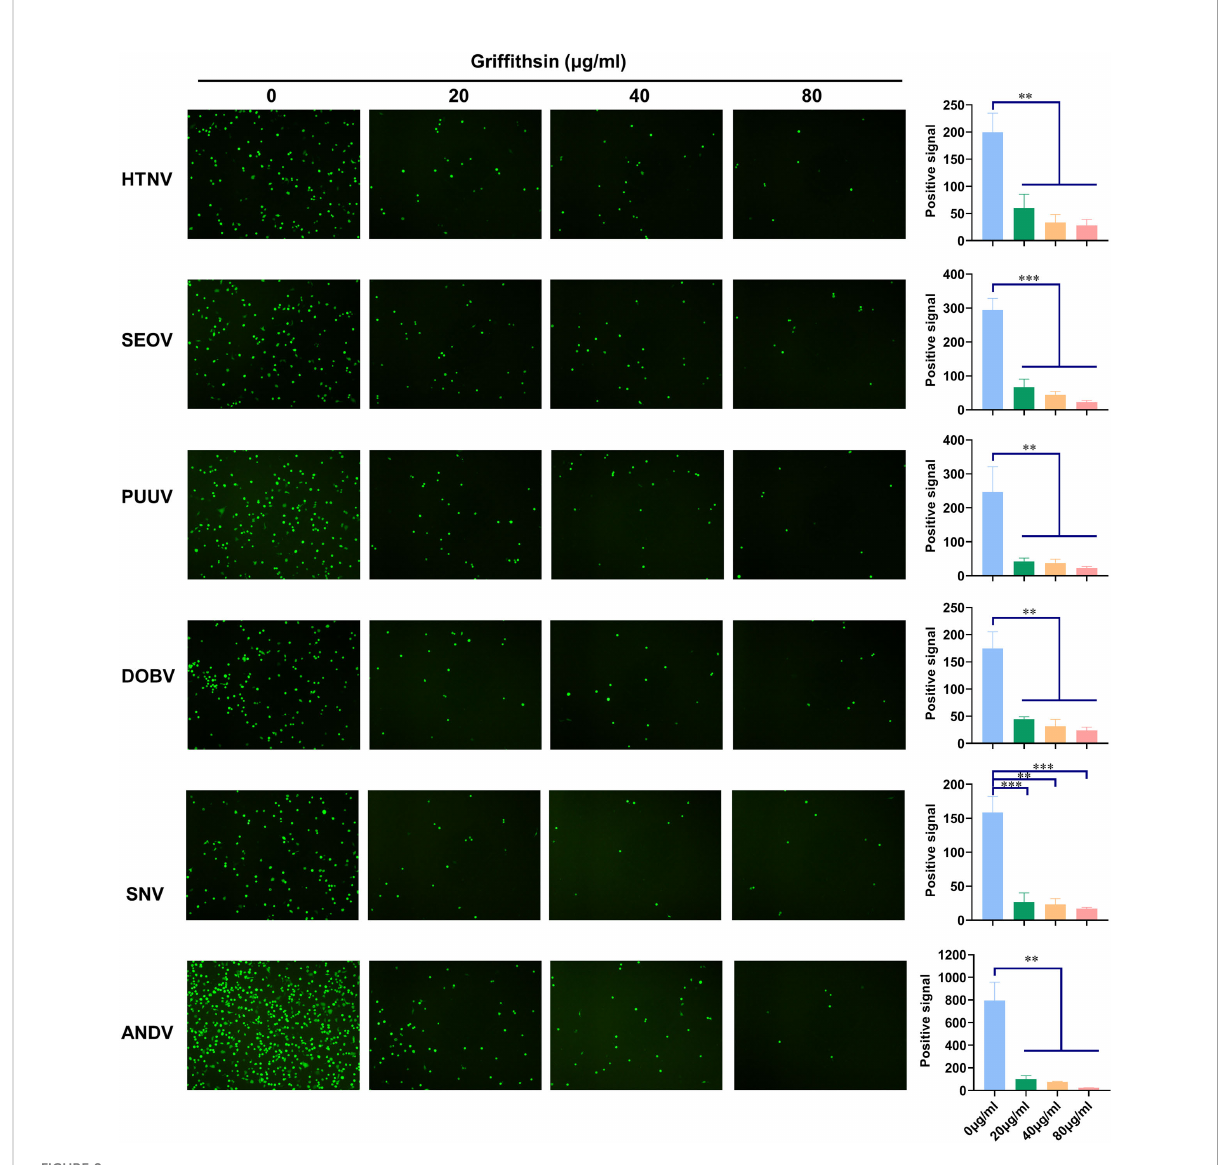
FIGURE 8 GRFT exerts pan-hantaviral inhibition effects. pVSV-based pseudotyped virus-bearing glycoproteins of HTNV, SEOV, PUUV, DOBV, SNV, and ANDV were prepared as indicated. pVSV of different hantaviral glycoproteins was pretreated with 20, 40, or 80 m g/ml of GRFT, and the mixture was used to inoculate A549 cells. Fluorescence was observed 24 h post-infection. Data shown in the graphs are presented as the mean ± SDs and are representative of three independent experiments, performed in triplicate. ** p < 0.01, *** p < 0.001. GRFT, grif fi thsin; pVSV, pseudotyped vesicular stomatitis virus; HTNV, Hantaan